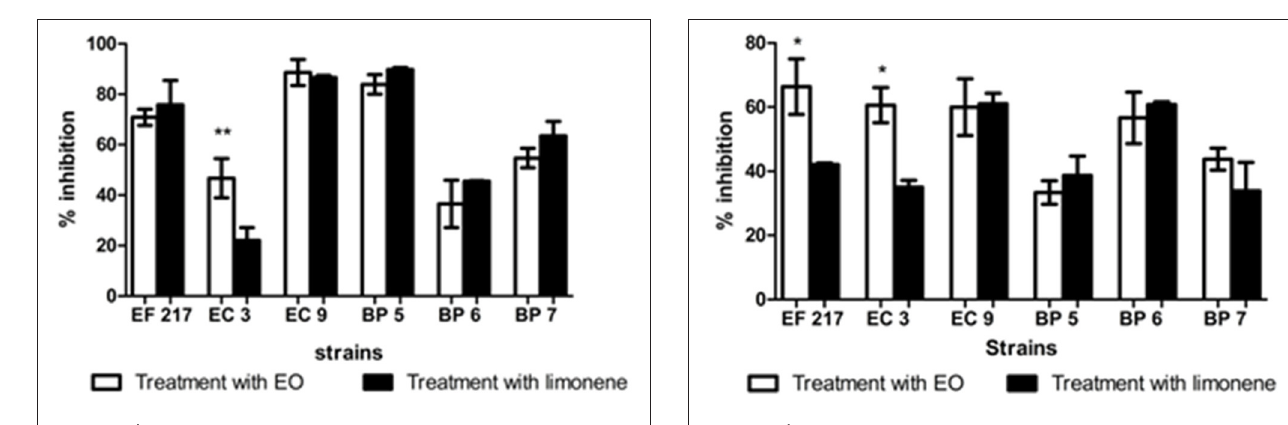
The results of MIC and MBC values showed that EO has antibacterial activity against clinical isolate bovine mastitis pathogens. MIC results showed that EO was able to inhibit the growth of all isolates tested in lower concentrations